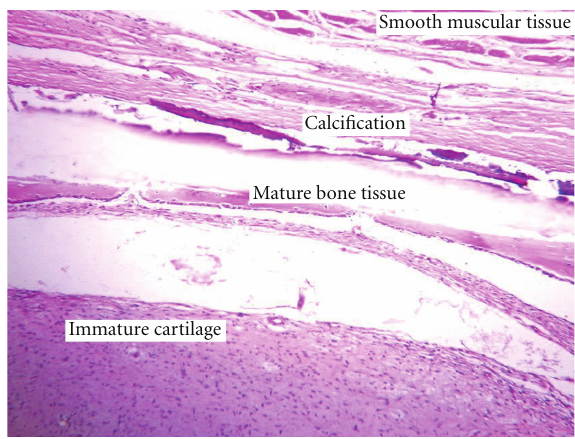
Figure 1: Postchemotherapy histology: mature teratoma (hema- toxylin and eosin stain × 10).